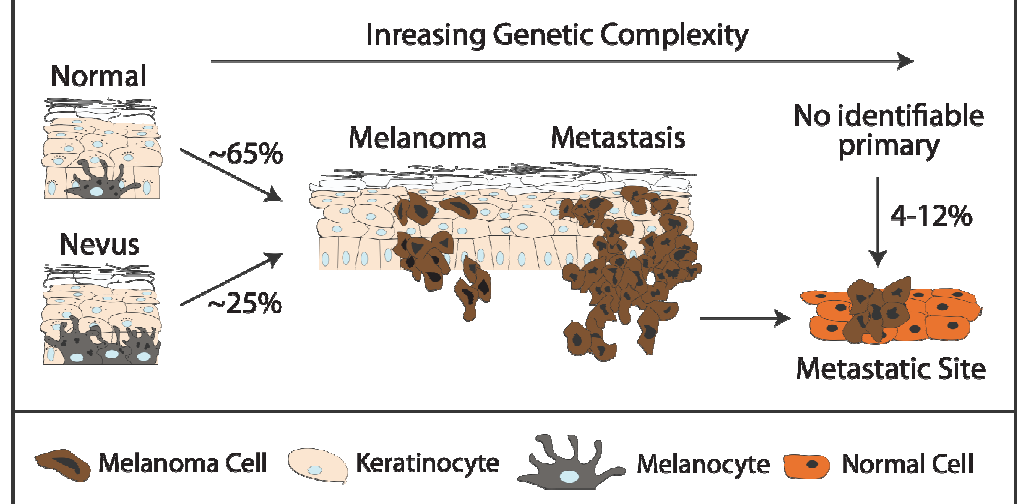
Figure 1. Origins of Metastatic Melanoma. Melanoma can arise either: (1) within a pre-existing melanocytic nevus (mole), generally associated with BRAFV600E mutation, or (2) with no visible precursor. Melanoma is thought to form within the epidermis, spread to the dermis, and ultimately to disseminate to distant sites (metastatic melanoma). Up to 12% of melanomas do not have an identifiable cutaneous precursor lesion. Progression of any individual lesion is thought to be driven by the acquisition of additional genetic/epigenetic